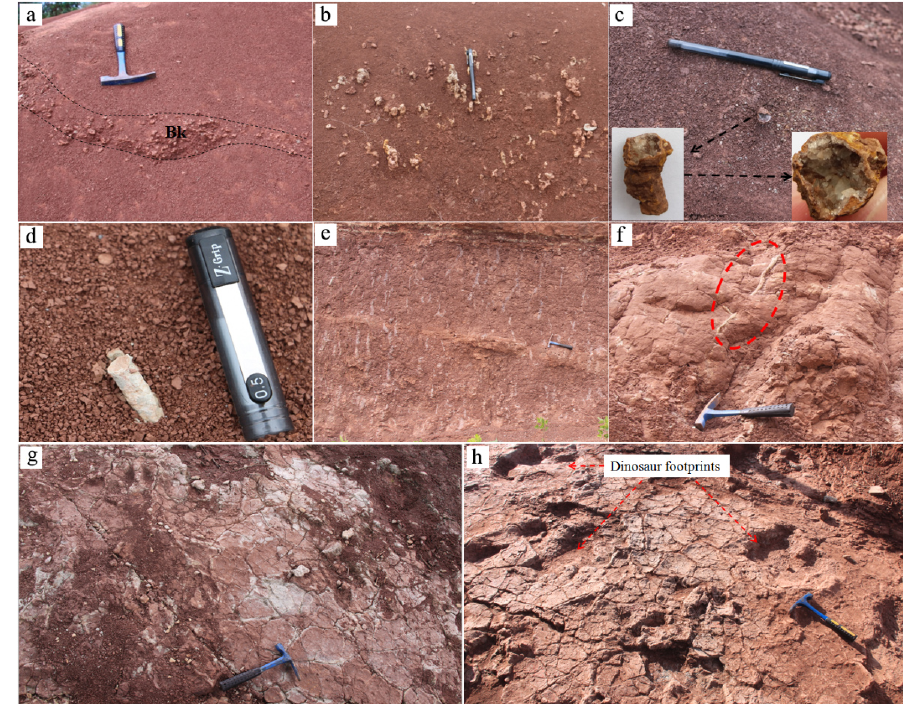
Figure 7. Evidence of palaeosols in the Datang profile: calcareous nodule layers generated during pedogenic processes (a, b) , wormhole remains filled with calcite (c) and grey mudstone (d) , root traces (e) , obvious rhizoliths (f) , and mud cracks (g, h)